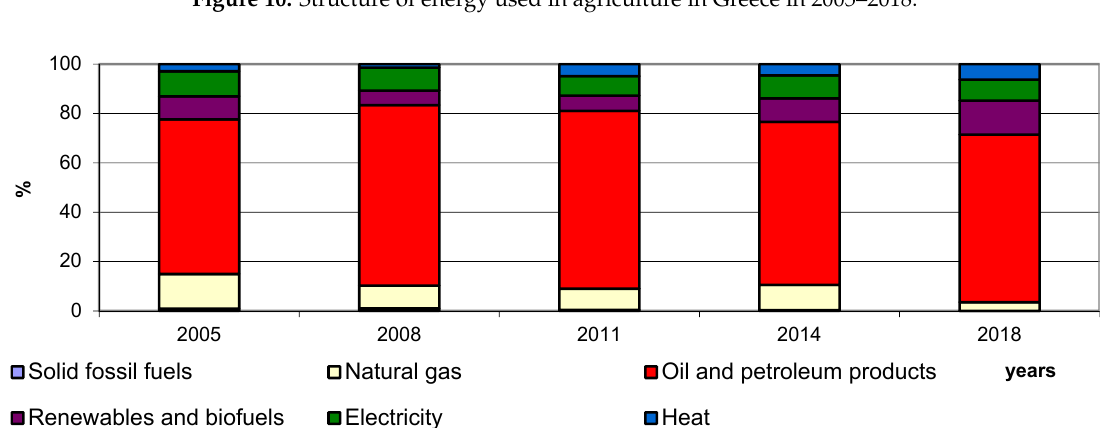
Figure 10. Structure of energy used in agriculture in Greece in 2005–2018.